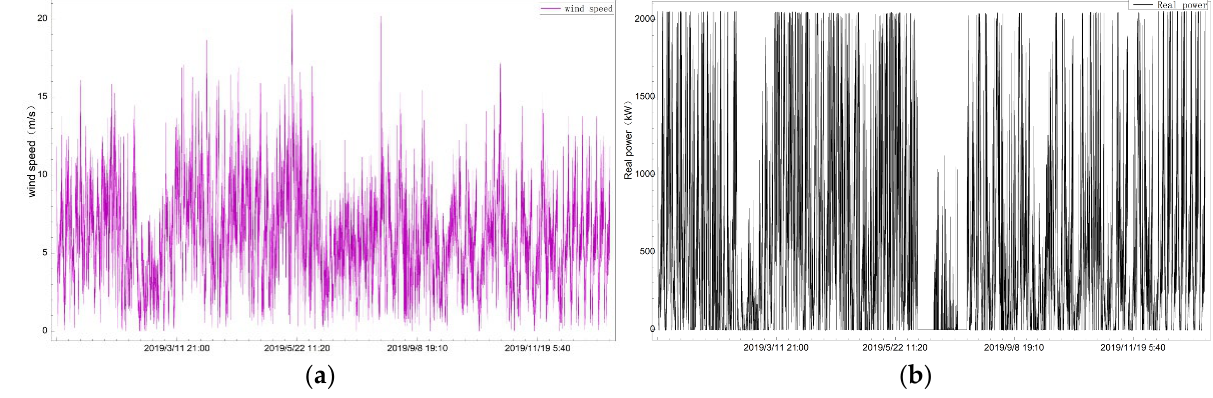
Figure 8. ( a ) Wind speed data and ( b ) output power production in one year.